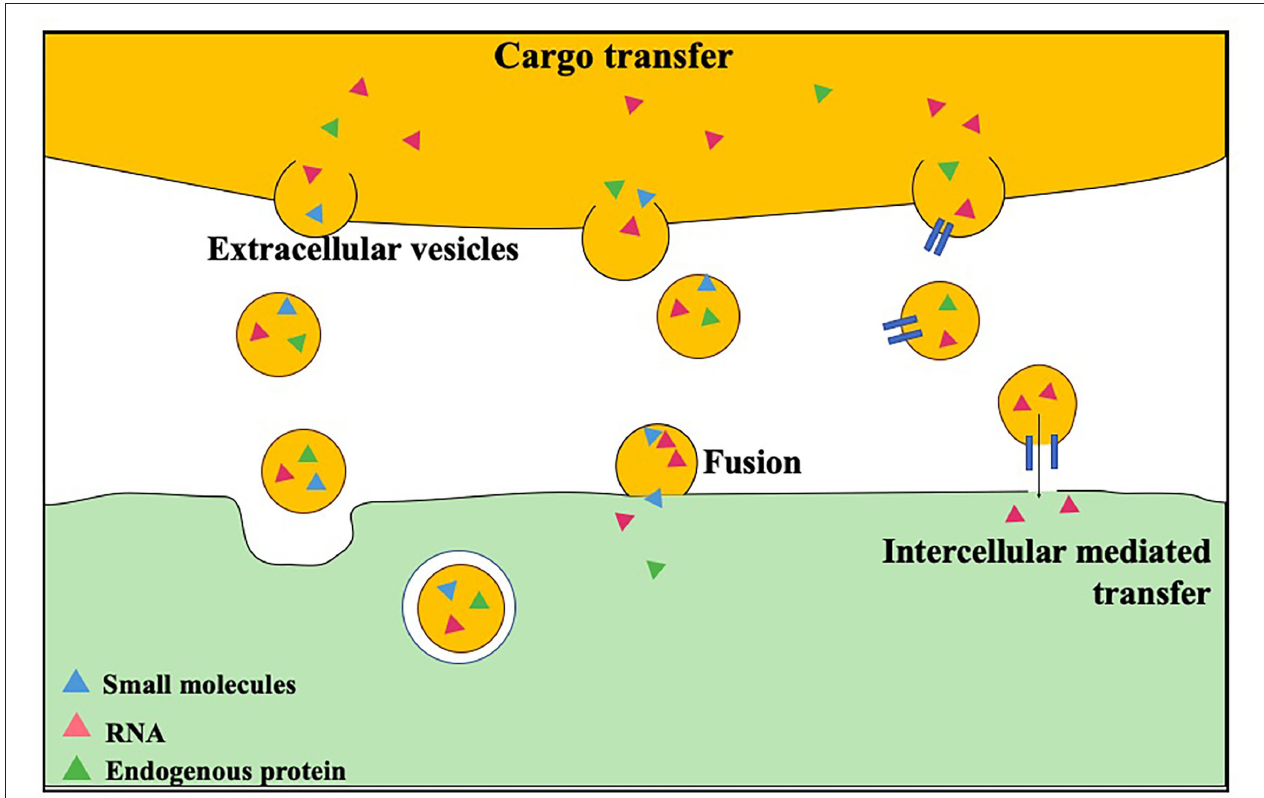
FIGURE 2 | Loading and transshipment of